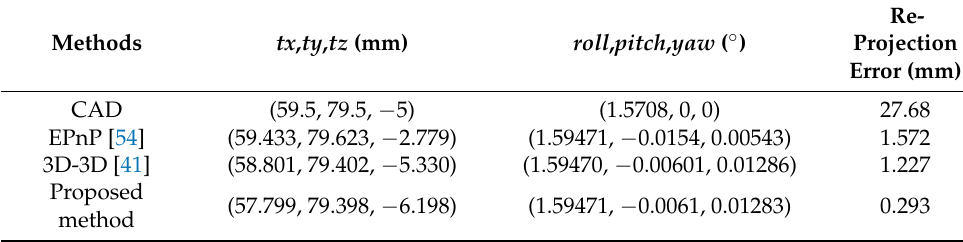
Table 4. Calibration results of RS-LIDAR-16 and